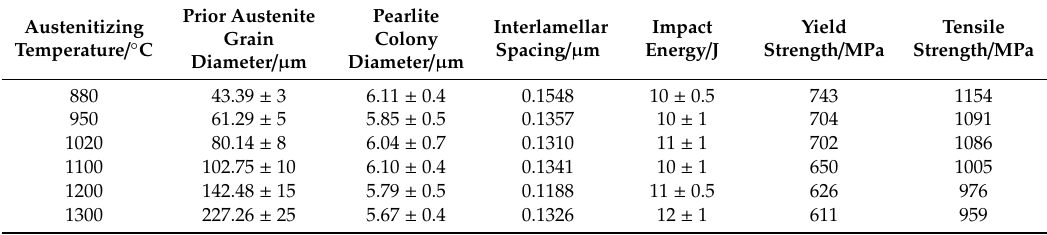
Table 2. Relationship between microstructure parameters and properties.